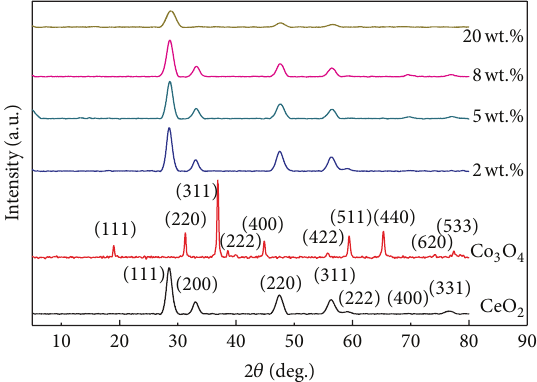
Figure2:XRDpatternofCo 3 O 4 /CeO 2 photocatalystswithdifferent mass faction of Co 3 O 4 doping.